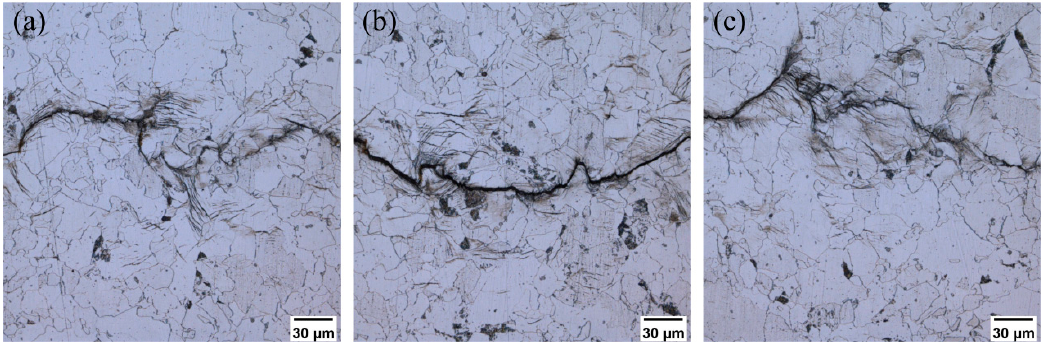
Figure 7. The local crack path of the TD1 specimen in three crack deflection regions: ( a ) region around a = 0.95 mm; ( b ) region around a = 1.25 mm; ( c ) region around a = 1.65 mm.